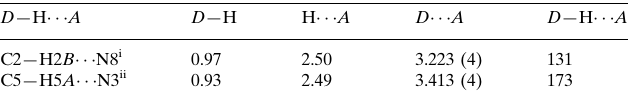
Hydrogen-bond geometry (A˚ , (cid:1) ). D —H (cid:2)(cid:2)(cid:2) A D